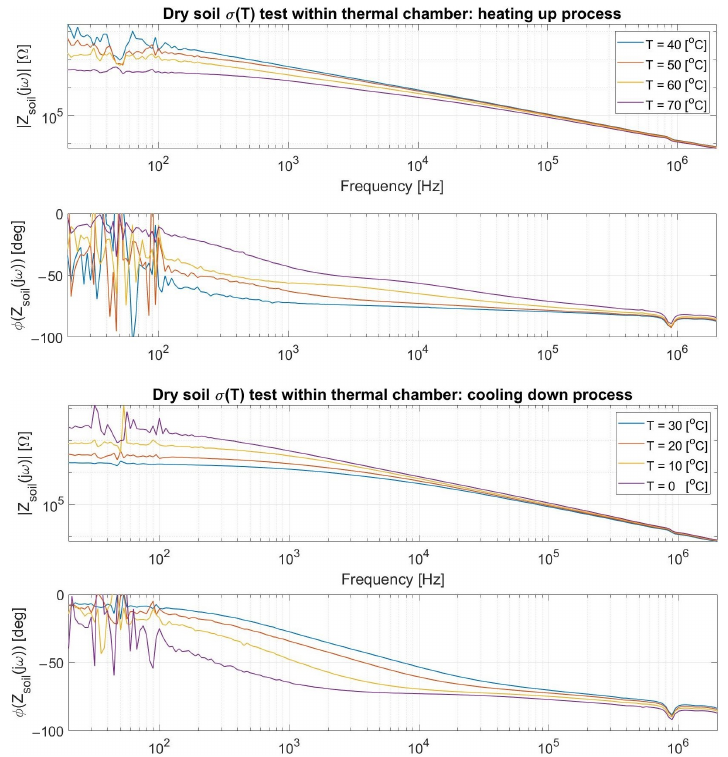
Figure 15. Yielded spectra for a set of temperatures via the current thermal chamber procedure.